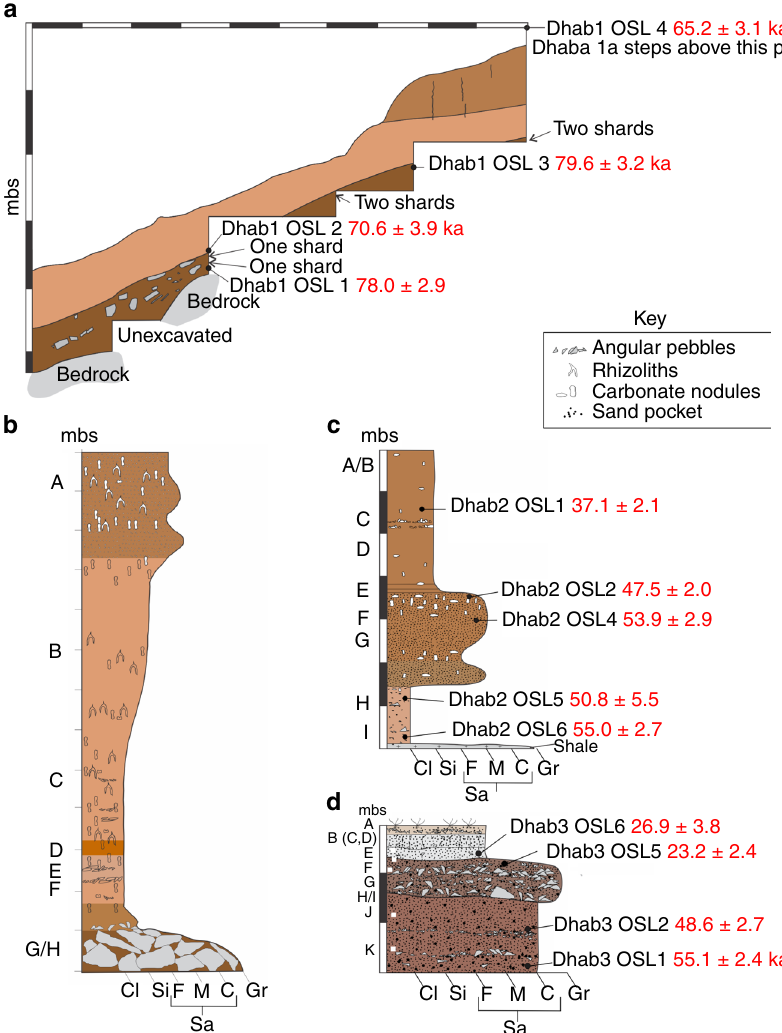
Fig. 3 Dhaba stratigraphy and chronology. a Dhaba 1 pro fi le showing location of IRSL ages and cryptotephra shards. The upper 7.88 m of Dhaba 1a are not shown. Note all glass shards are found at or below the boundary between the yellow-brown clay-rich layer and the overlying light yellowish brown silt layer and are bracketed by ages of 78 and 71 ka. b Dhaba 1 sediment log. c Dhaba 2 sediment log and IRSL ages. d Dhaba 3 sediment log and IRSL ages. Cl = clay, Si = silt, Sa = sand (F, M and C are fi ne, medium and coarse, respectively), Gr = gravel, mbs = metres below surface. Alphabetial references are to stratigraphic layers. Refer to Supplementary Table 1 for detailed sedimentary